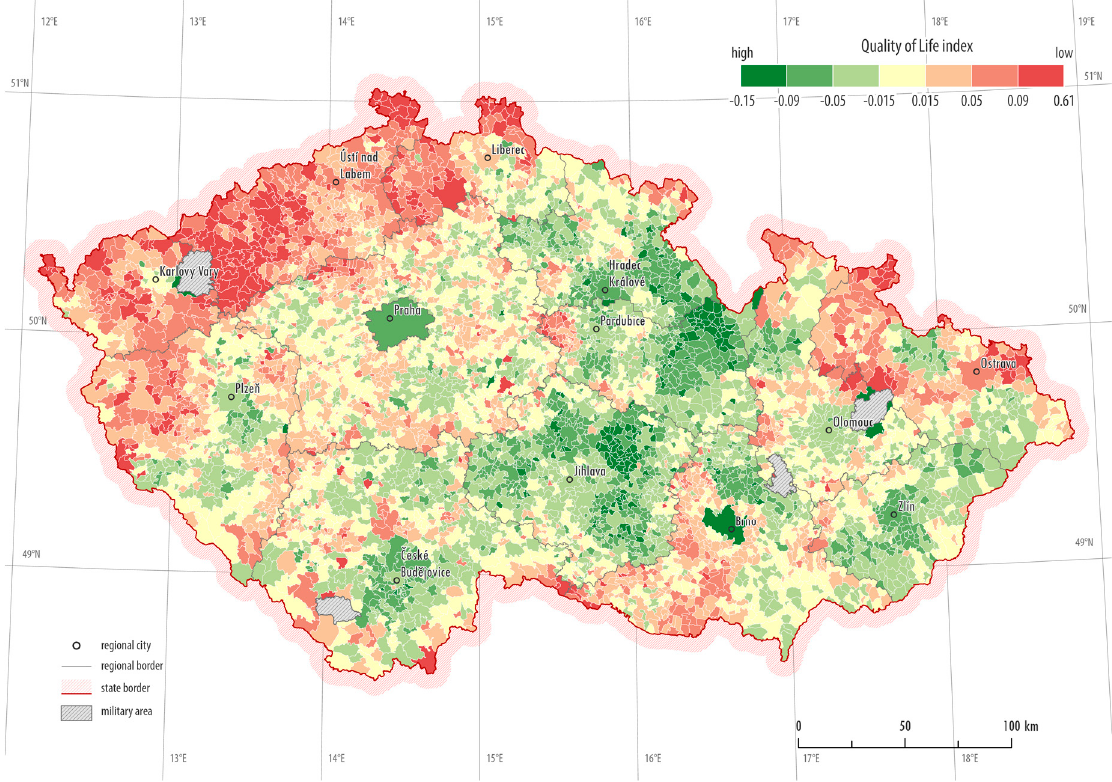
Figure 1. Original index with time-updated input